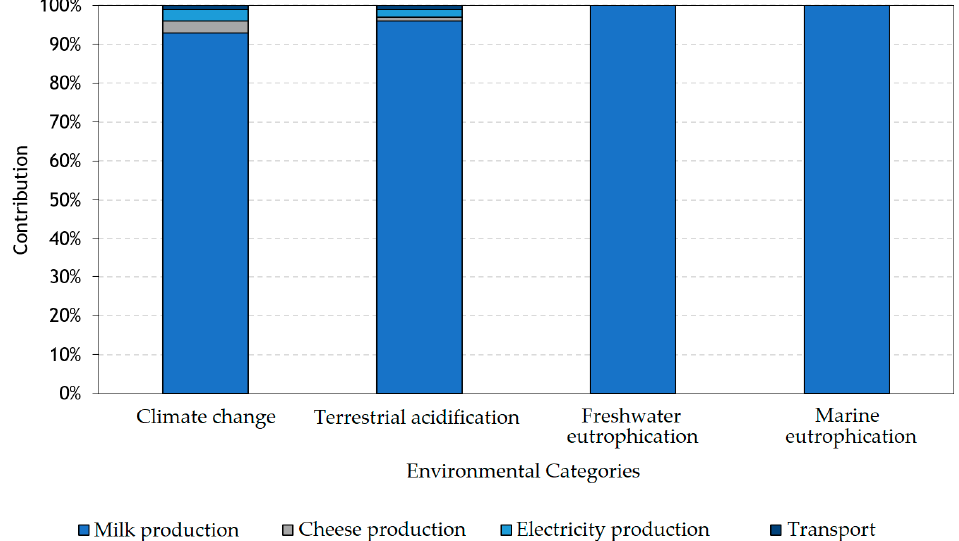
Figure 4. Relative contribution of involved system processes for cheese production by impact category.